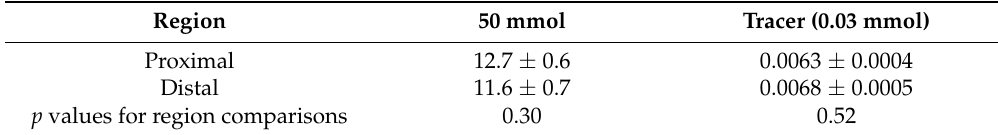
Table 1. Rates of methylsulfonylmethane (MSM) absorption (nmol/mg-min) by the proximal and distal small intestine when measured at MSM concentrations of 50 mmol and tracer. Values are means and stnadare error of the mean.